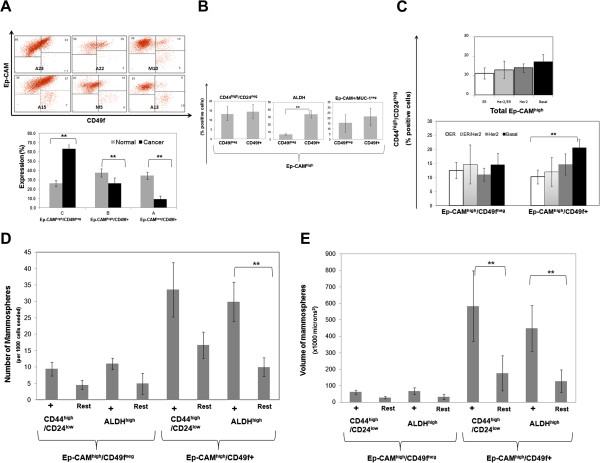
CSC are abundant in primary CD44high/CD24low/Ep-CAMhigh/CD49+ cancer cells. A) Representative dot plots for Ep-CAM/CD49f profile of tumor cells from different breast cancer patients as analyzed by flow cytometry (top) and histogram showing percentage of each Ep-CAM/CD49f population (n = 9 for normal breast and n = 13 for breast cancer samples). Lineage negative (CD45neg, CD10neg, CD31neg) cancer cells were gated followed by exclusion (gating out) of Ep-CAMneg/CD49fneg mesenchymal fraction. Numbers in the corners indicate percentage of cells in each quadrant. B) Expression level of each of the studied stem/progenitor cell markers in Ep-CAMhigh/CD49fneg and Ep-CAMhigh/CD49f + cell fractions in 16 breast cancer patients gated as in A. C) Percentage of CD44high/CD24low/Ep-CAMhigh cancer cells (top) and after fractionation into CD49fneg or CD49f + cells (bottom). Cases were stratified to four subtypes of breast cancers based on their estrogen receptor (ER), progesterone receptor (PR) status, as well as overexpression of Her2 as following: ER = ER+/PR+/Her2neg, ER/Her2 = ER+/PR+/Her2+, Her2 = ERneg/PRneg/Her2+, and basal = ERneg/PRneg/Her2neg, D&E) Mammosphere formation, measured by either number (D) or size (E) of tumor cells sorted for the stem/progenitor markers CD44high/CD24low or ALDHhigh and expressed within Ep-CAMhigh/CD49fneg or Ep-CAMhigh/CD49f + breast cancer cell subpopulations (means ± S.E.M, n = 7). **indicates statistical significance.